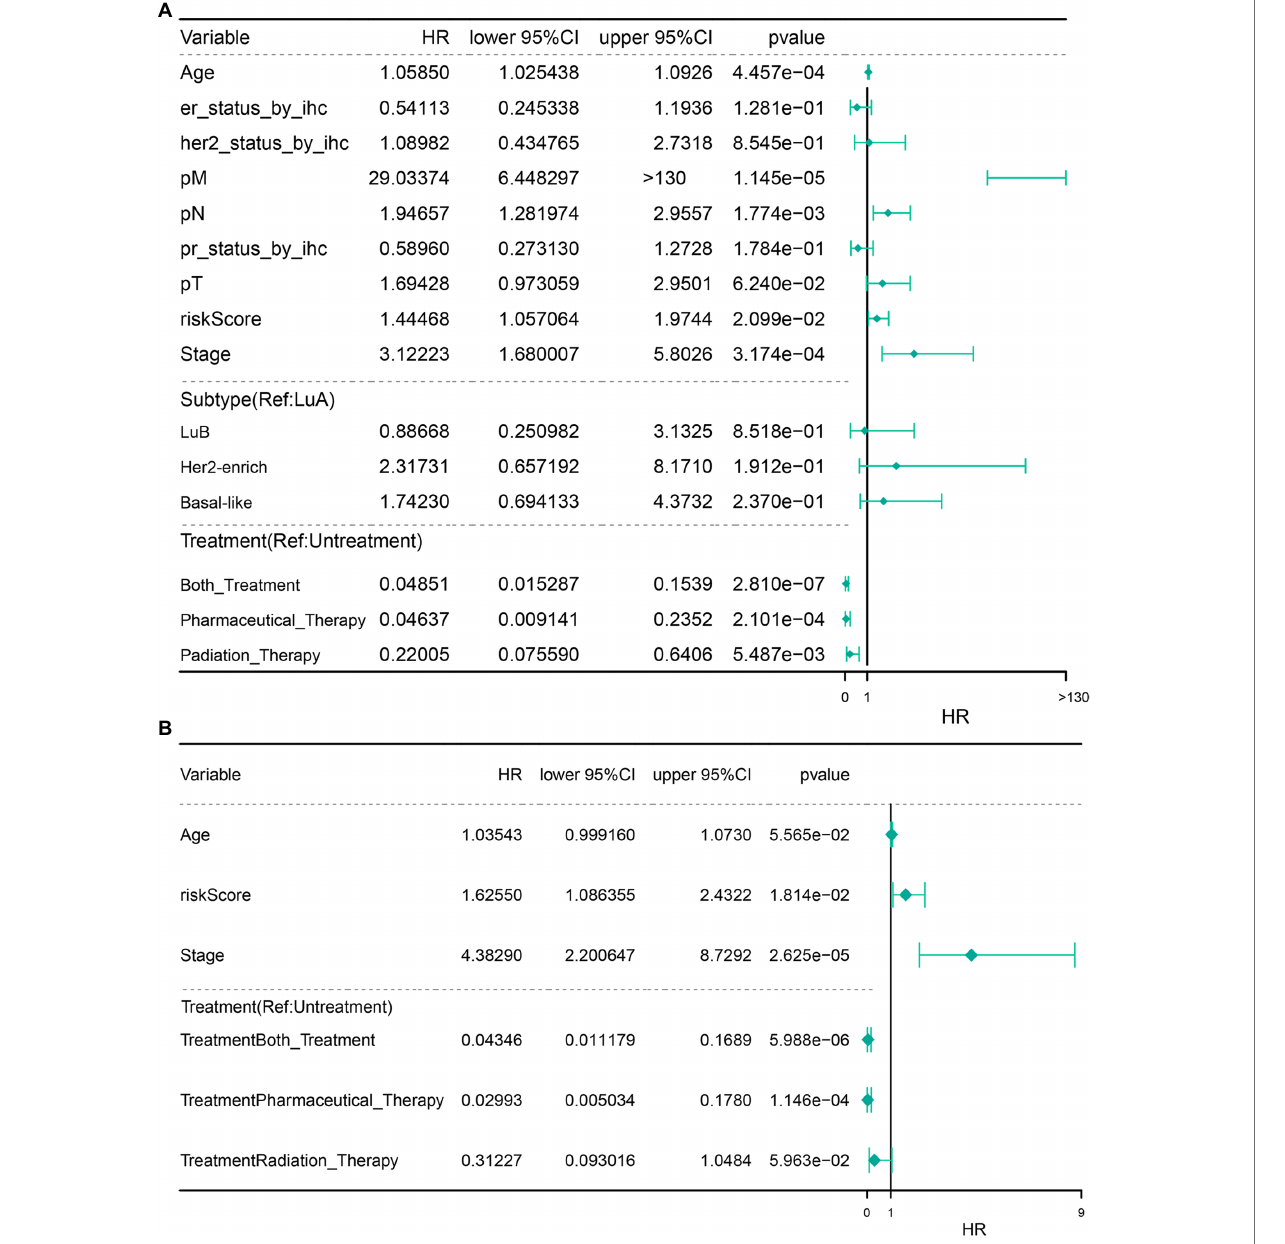
FIGURE 7 | Independent prognostic analysis. (A) Independent prognostic univariate Cox regression analysis. (B) Independent prognostic multivariate